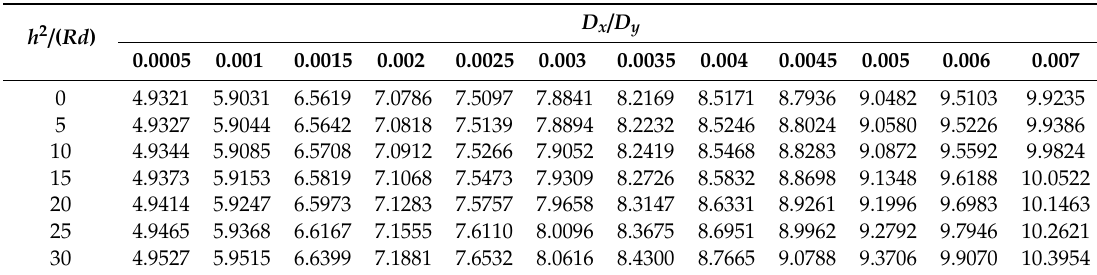
Table 5. Global shear buckling coe ffi cient k g , f for various values of h 2 / ( Rd ) and D x / D y when l / h = 5, γ = 0.4 and β = 1.8 α for the four-edge fixed support.